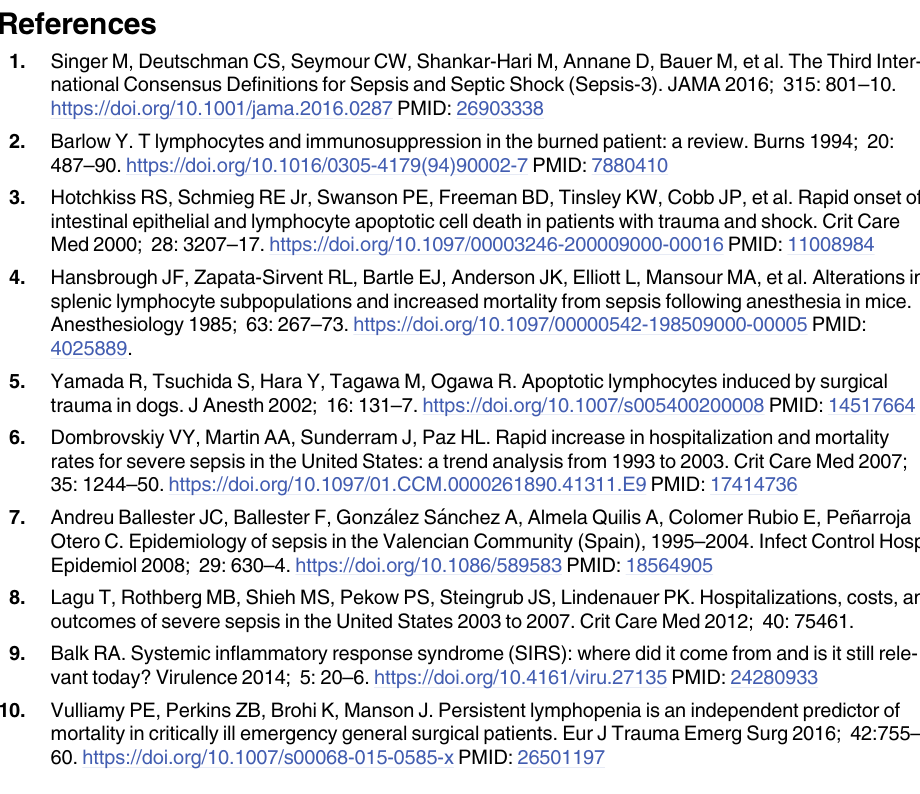
S2 Table. Significant association lymphopenia according to infectious diseases (CIE-10). S1 Appendix. Number of diagnoses in each patient according to disease groups. Each patient can have multiple diagnoses, so there are more diagnoses than patients. S1 Appendix shows the number of patients who have one or more diagnoses at the same time according to disease groups. Finally, it can see that the sum of the totals is equal to the sum of the diagnoses.